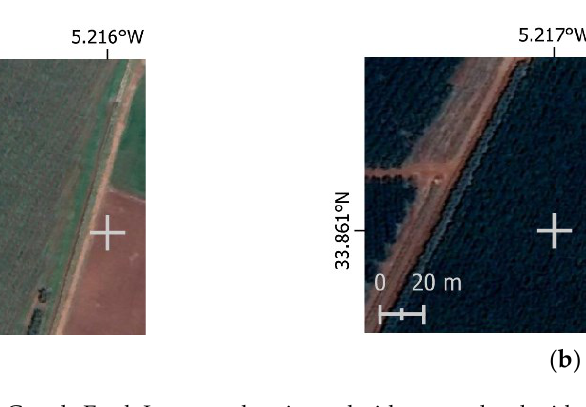
Figure 8. Google Earth Imagery showing a deciduous orchard with winter soil greening during the winter ( a ) and with full crown size for comparison during the summer ( b ).